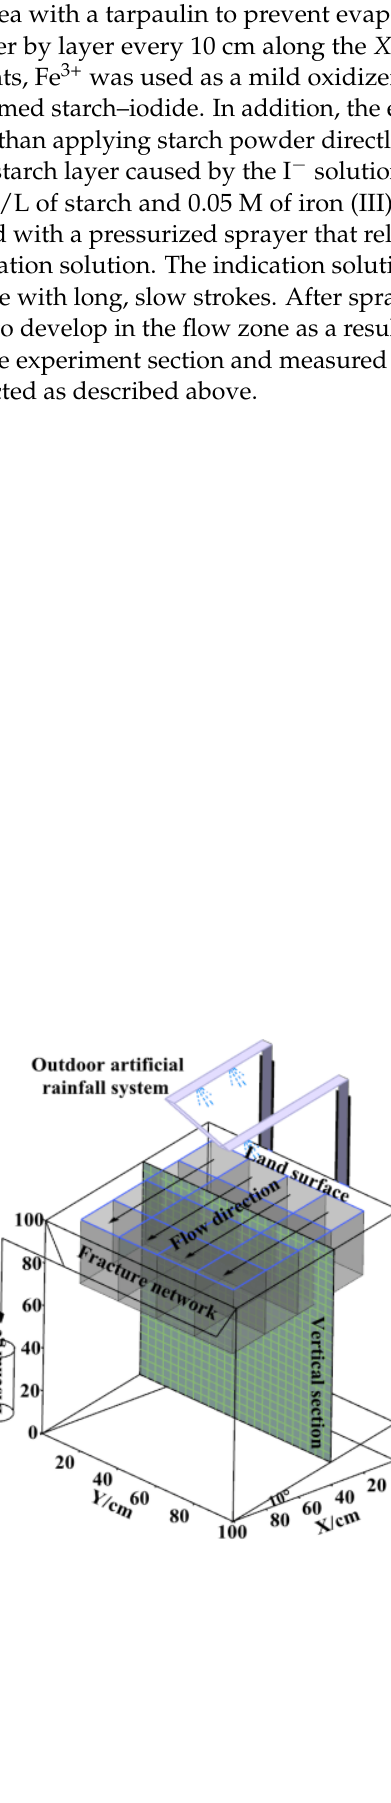
( b ) Figure 4. ( a ) The original image after correcting for lighting and geometric distortion; ( b ) a binary image after applying the dye detection algorithm. Calculate the preferential flow parameters and quantify the preferential flow charac- teristics based on the binary data from image processing. The variability of soil moisture flow is quantified by the actual infiltration depth ( ID ), the movement track of the vertical profile is quantified by the dyed area ( DC ), and the infiltration uniformity S2 is used to indicate whether the soil moisture infiltrates to a uniform depth in the cracked area and matrix area.